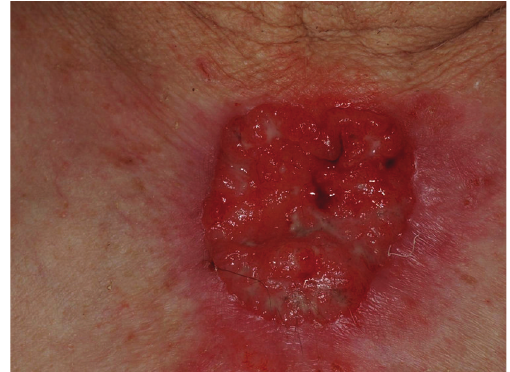
Figure 6: Case 4: An ulcerated tumor on the patient’s presternal area.